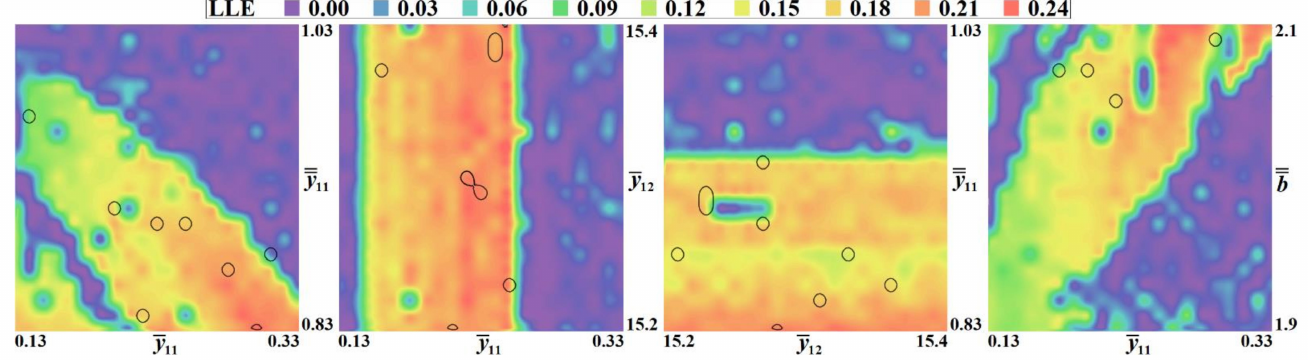
Figure 11. Resonant amplifier with Darlington-type composite, fourth order system considered for analysis. Rainbow-scaled composition of contour plots of two LE, circled areas combined filled with orange or red color denote parameter configurations leading to distinguished hyperchaotic motion (positive value of both first and second LE), unified color scale legend for LLE is included.